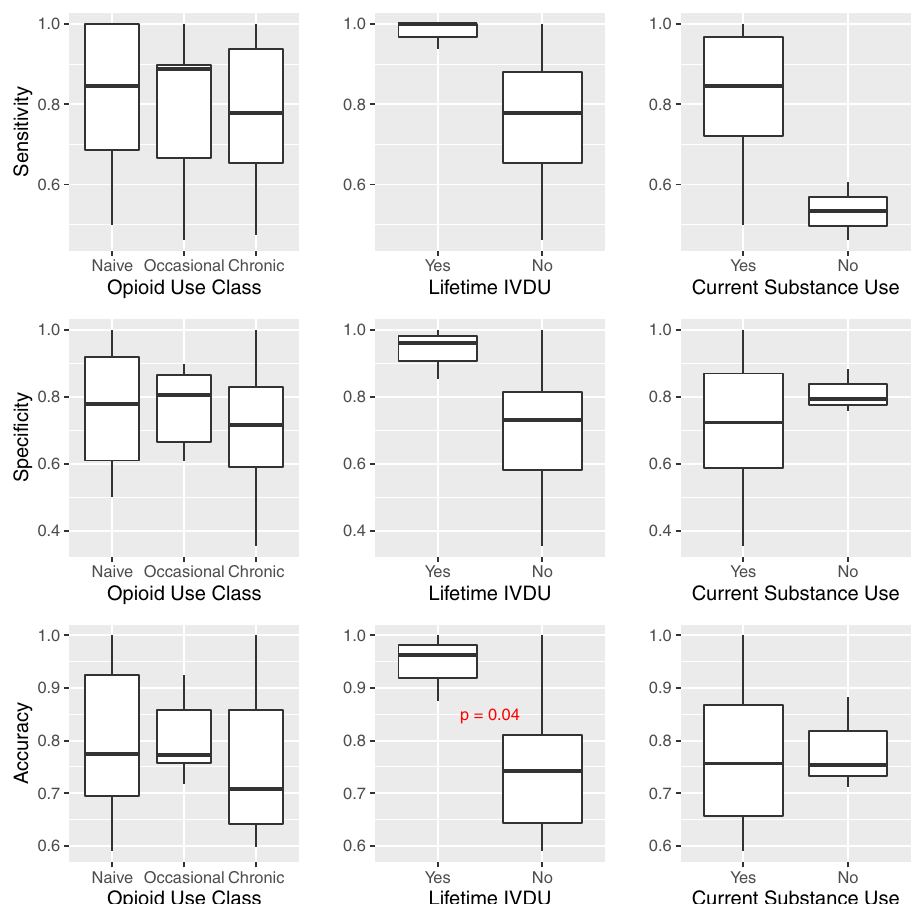
Fig. 4 Model metrics strati fi ed by substance use history. Center line = median; upper bound of box = 75th percentile; lower bound of box = 25th percentile; and whiskers = minimum to maximum range, with extreme outliers denoted by black dots. P value based on Wilcoxon rank-sum test. IVDU intravenous drug